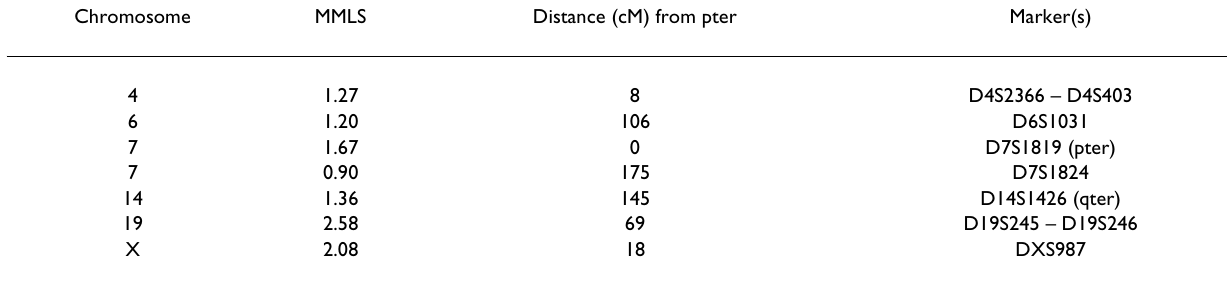
Table 2: Maximum MLSs for the seven regions exceeding the stage 1 threshold Chromosome MMLS Distance (cM) from